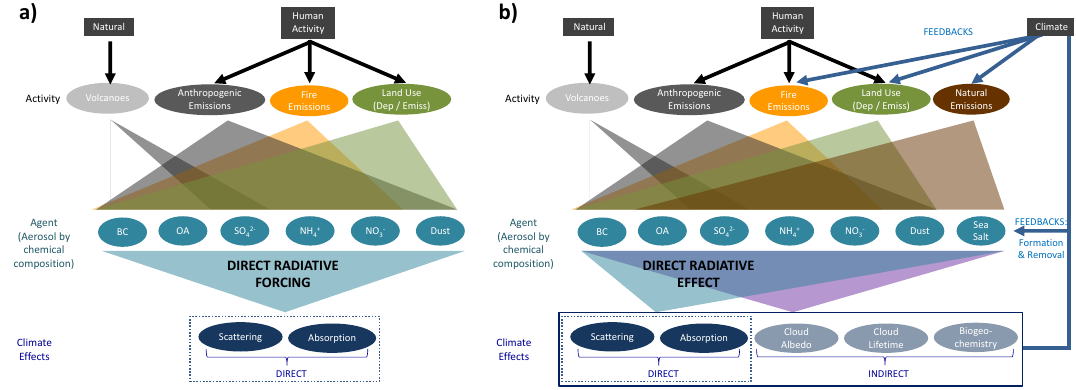
Figure 6. Illustration highlighting the difference between the estimate of (a) direct radiative forcing (left) and (b) direct radiative effect (right). DRF is the perturbation (since pre-industrial) associated with human activity and natural forcing (i.e., volcanoes). DRE characterizes the instantaneous impact of all aerosols on radiation (including any feedbacks and natural